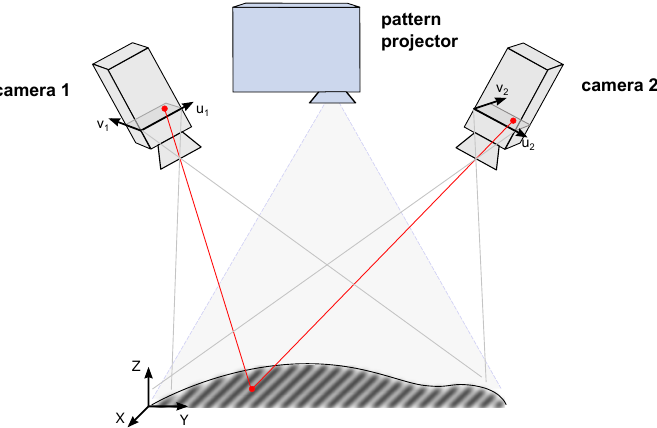
Figure 3. Triangulation of a 3D point (red) for a stereo camera sensor with pattern